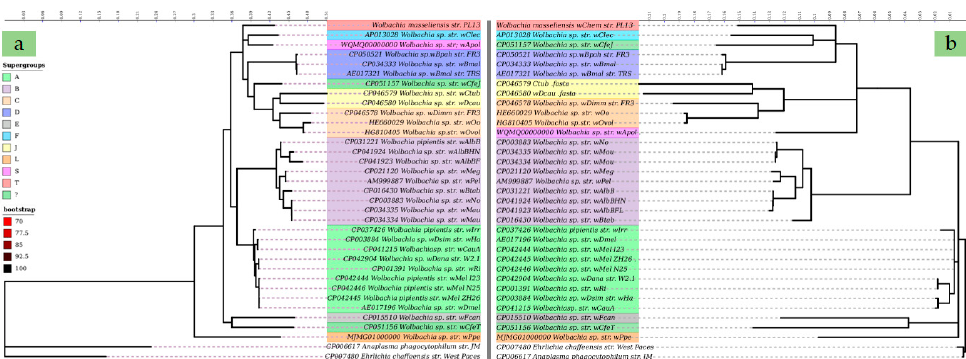
Figure 5. Comparative phylogenies showing the position of the wChem PL13 strain among the other Wolbachia supergroups. ( a ). IQTREE based on ML method with 1000 bootstraps from the concatenated ten selected genes using GTR (+F+R3) substitution model [49]. Outgroup taxons “ Ehrlichia chaffeensis (CP007480) and Anaplasma phagocytophilum (CP006617)” are drawn at root. Log-likelihood of consensus tree is − 88934.819989. ( b ). Genome based phylogeny generated using the FastTree Version 2.1.10, double precision (No SSE3) [50]. The tree was rooted using Jukes-Cantor Joins model with 1000 local boots. The nearest-neighbor interchange (NNI) and the subtree pruning and regrafting (SPR) (2 rounds range 10) were used for the tree rearrangement. The Top Hits was 1.00 *